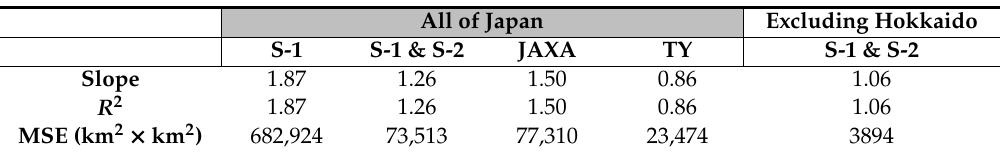
Figure 7. Comparison of paddy field maps of eastern Japan developed in this study with existing maps. Paddy fields in 2018 on the maps developed by the ( a ) S-1 and ( b ) S-1 & S-2 methods (30 m spatial resolution). ( c ) Paddy fields in 2014–2016 on the JAXA map (30 m spatial resolution). ( d ) Paddy fields in the early 2000s on the TY map (1 km spatial resolution). Table 4. Slopes of straight lines fitted to the relationships shown in Figure 9 with the y -intercept fixed at 0, together with the coe ffi cients of determination ( R 2 ) and the mean square errors (MSE) relative to the MAFF